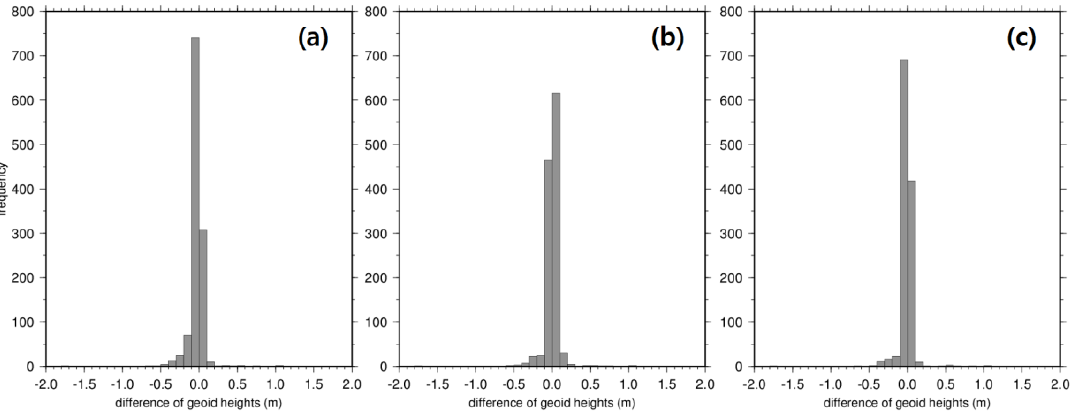
Figure 7. Histograms of the differences between the geoid heights (𝑁 𝐺𝑁𝑆𝑆/𝑙𝑒𝑣𝑒𝑙𝑖𝑛𝑔 ) derived from GNSS/leveling on the 1182 UCPs and the geoid heights (𝑁 𝐾𝑁𝐺𝑒𝑜𝑖𝑑 ) derived from the three KNGeoid models. ( a ) KNGeoid13; ( b ) KNGeoid14; and ( c ) KNGeoid18.